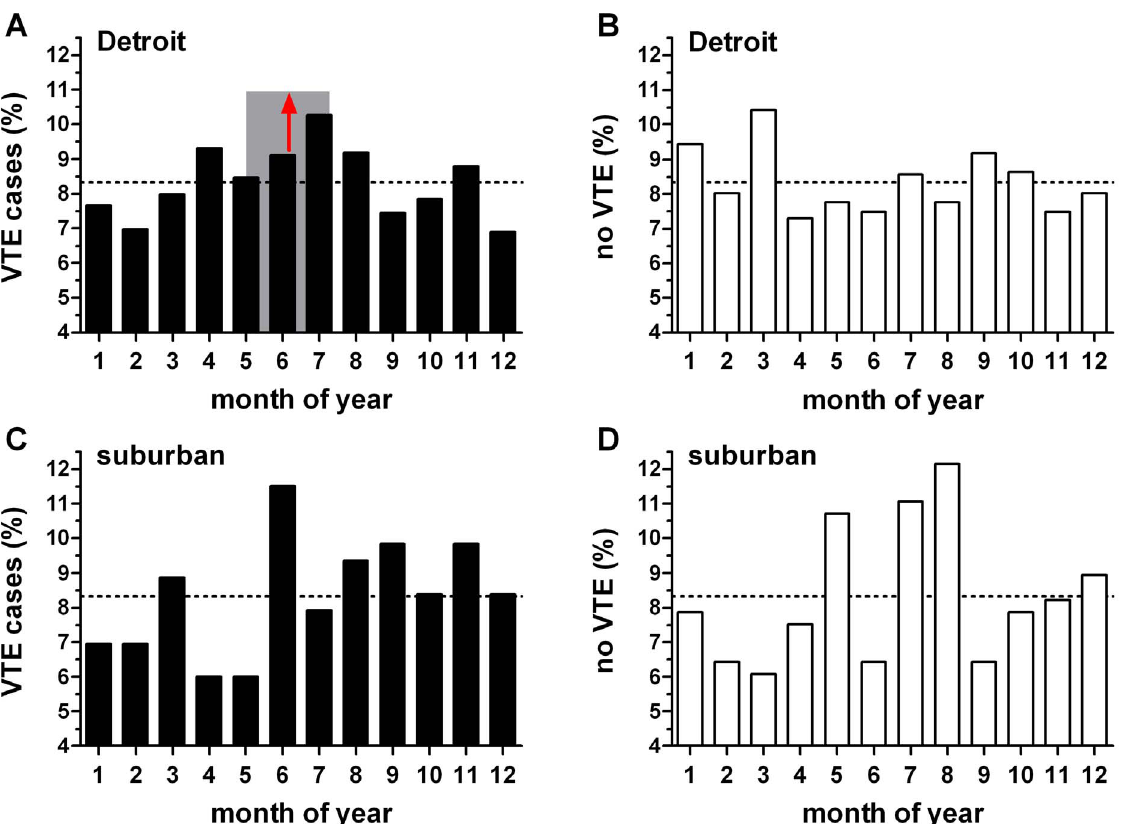
Figure 3. Distribution of monthly venous thromboembolism (VTE) and no-VTE cases. X-axis indicates the month of the year (January=1). Dashed line indicates uniform distribution. (A) Detroit VTE (n=1,490). This was the only distribution that differed from uniform ( P =0.0046; Rayleigh test). Distribution mean (red arrow) June 24 th ; the 95% confidence intervals (May 19 th to July 31 st ) are indicated by the shaded rectangle. (B) Distribution of Detroit cases that did not have a VTE (n=1,123); did not differ from uniform ( P =0.50), but differed from the Detroit VTE cases ( P , 0.02; Kuiper’s test). (C) Suburban VTE (n=417); did not differ from uniform ( P =0.13). (D) Suburban cases that did not have a VTE (n=280); did not differ from uniform ( P =0.21) or the suburban VTE distribution.